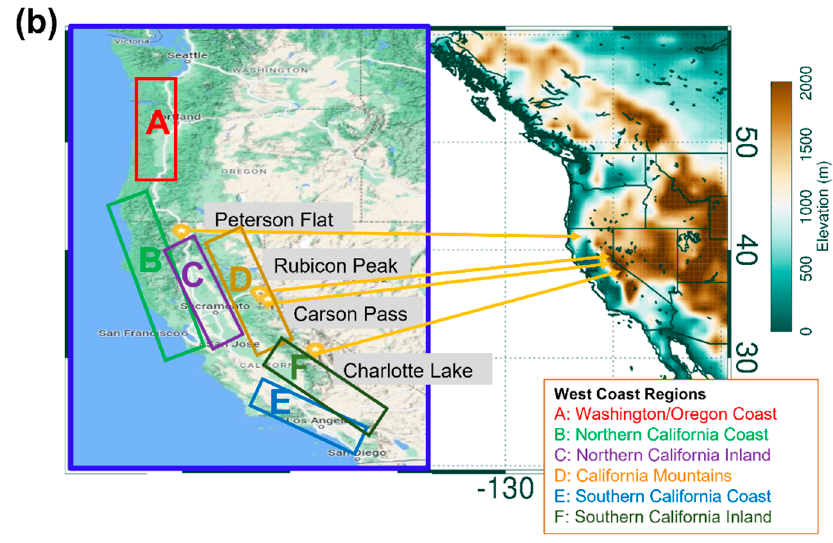
Figure 1. ( a ) The example of GPM precipitation for the 8 January 2017 AR event, striking the western U.S (figure credit: NASA GPM [23]). ( b ) The elevation map of the western U.S. and snowpack site (Peterson Flat (41.3° N, 122.5° W), Rubicon Peak (39.0° N, 120.1° W, Carson Pass (38.7° N, 120.0° W), and Charlotte Lake (36.8° N, 118.4° W)) in the western U.S. The blue box refers to the AR characteristic study (A–F) region and snowpack observation sites (yellow dot and arrows).